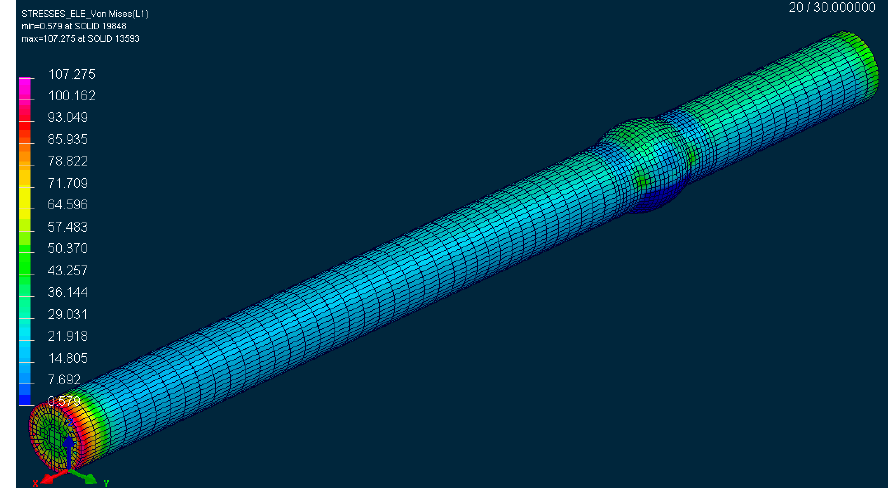
Figure 24. The reduced stress according to the hypothesis HMH in the tested sample after welding in the period t = 30 s, according to the simulation designed in the software SysWeld.